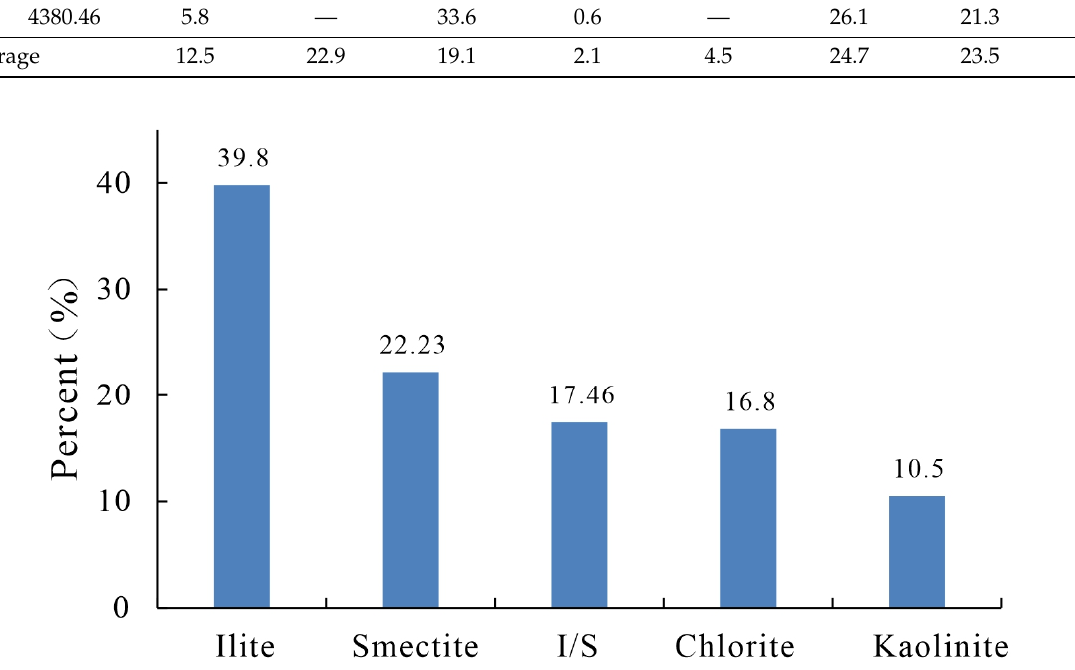
Figure 4. Clay mineral analysis results of the Permian Lucaogou Formation in the Jimsar Sag.